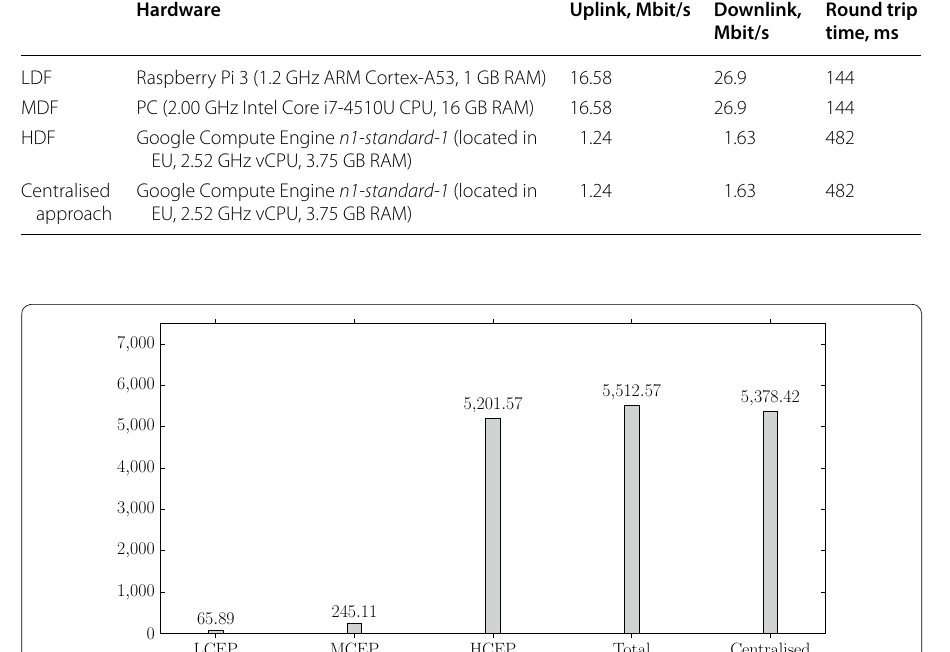
Table 4 Testbed hardware specs and network speed test Hardware Uplink, Mbit/s Downlink,